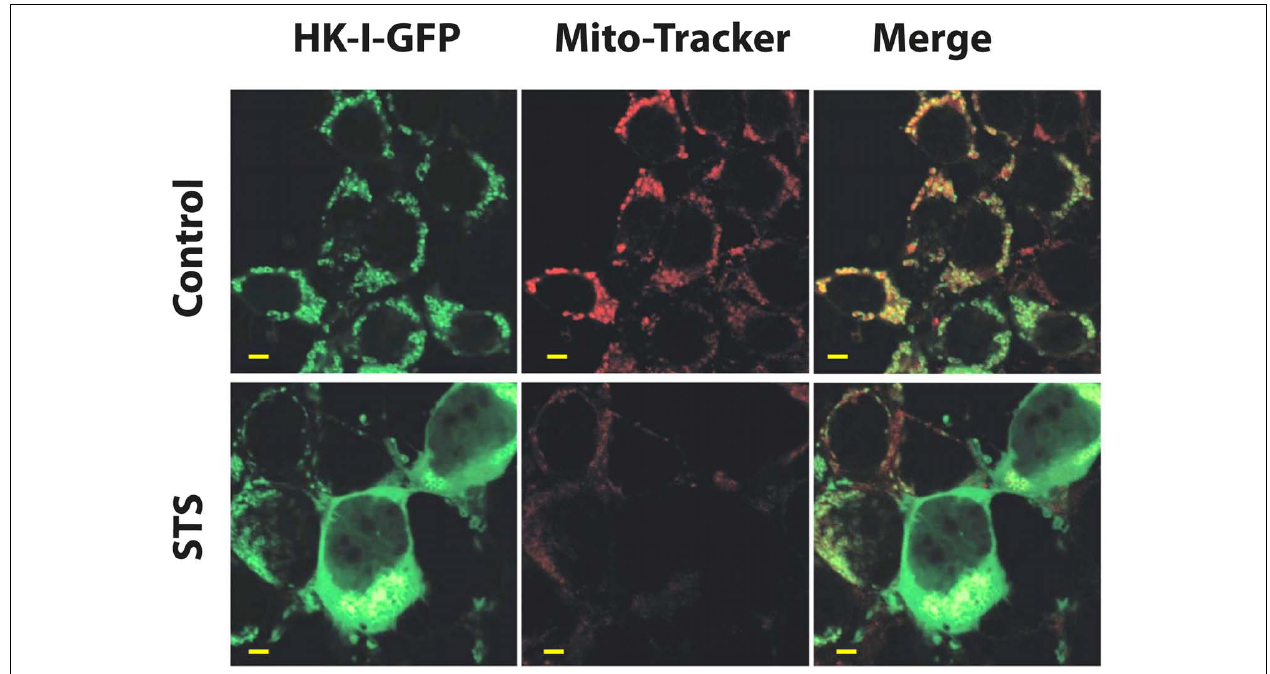
HK-I–GFP and after 48 h were exposed to STS (0.8 μ M), stained with 25 nM of the mitochondrial marker MitoTracker Red and visualized with confocal microscopy.The punctuated HK-I–GFP fluorescence, originally co-localized with mitochondria (control), as also reflected in the co-localization with MitoTracker Red (Merge panel), was converted to diffuse labeling of the cytosol after exposure to STS. Images are representative microscopic fields from one of three similar experiments (scale bar = 5 μ